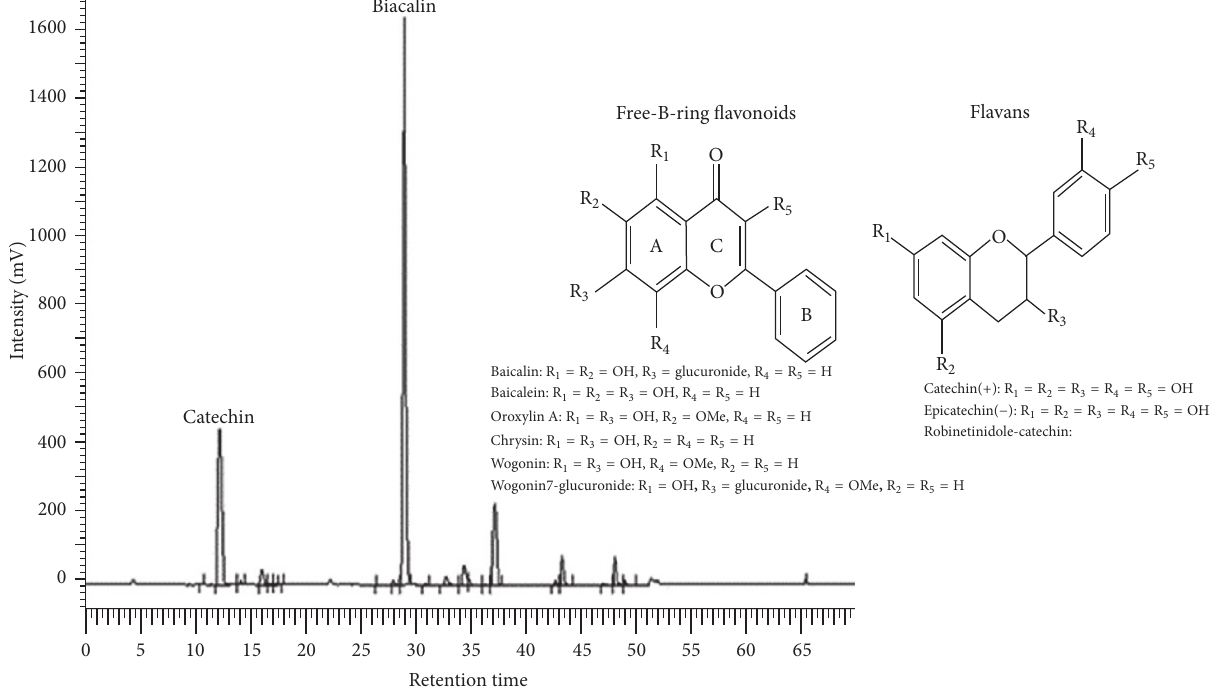
Figure 1: HPLC chromatogram and chemical structure of free-B-ring flavonoid (baicalin) and flavan (catechin). The flavonoids were detected using a UV detector at 275 nm and identified based on retention time by comparison with known flavonoid